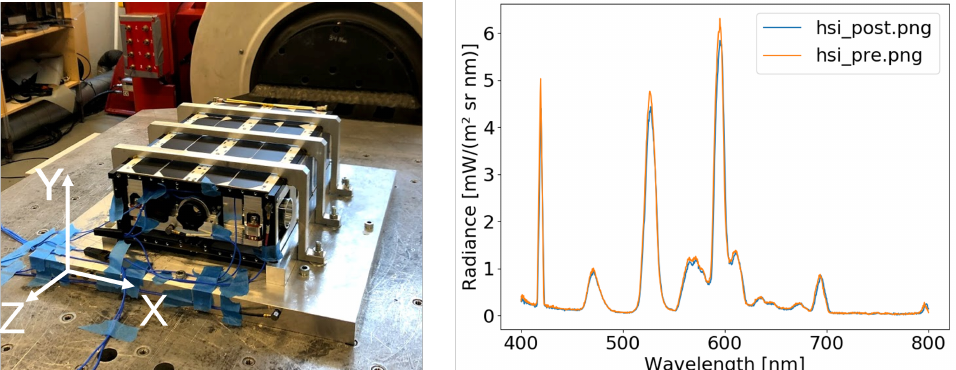
Figure 14. ( Left )MM including payload QM mounted to vibration table. This setup was used to simulate shock as well. ( Right ) Center line spectral response recorded before (pre) and after (post) shock and vibration testing in the “Y” axis (the axis with the greatest response to vibrations; “X” and “Z” axis responses are not shown, but have less variation). Plotted results are cropped from 400 nm, low-end sensitivity cutoff of the sensor, to 800 nm, since the quantum efficiency of the sensor falls below 20% for wavelengths greater than 800. Note: spectral images were taken while the satellite was mounted to the table—slight variations in the ambient temperature, pressure, and humidity in the room could have minor influences on the plotted results.